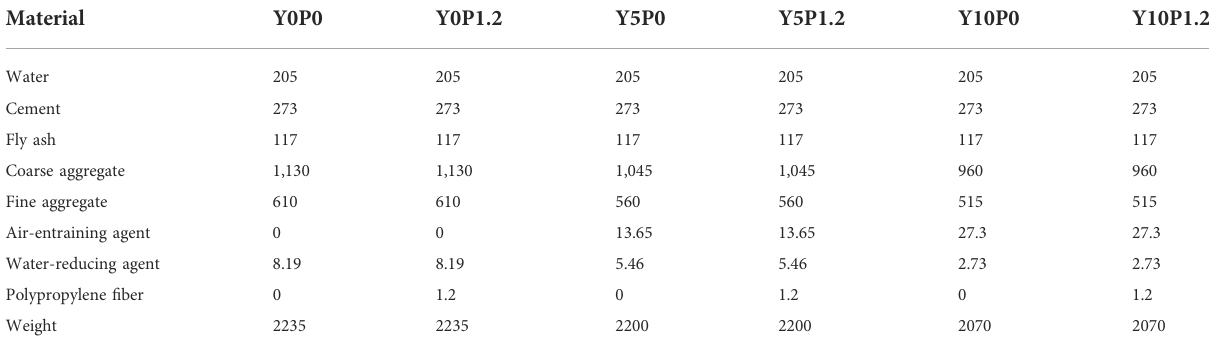
TABLE 2 Detailed composition/(kg/m 3 ).